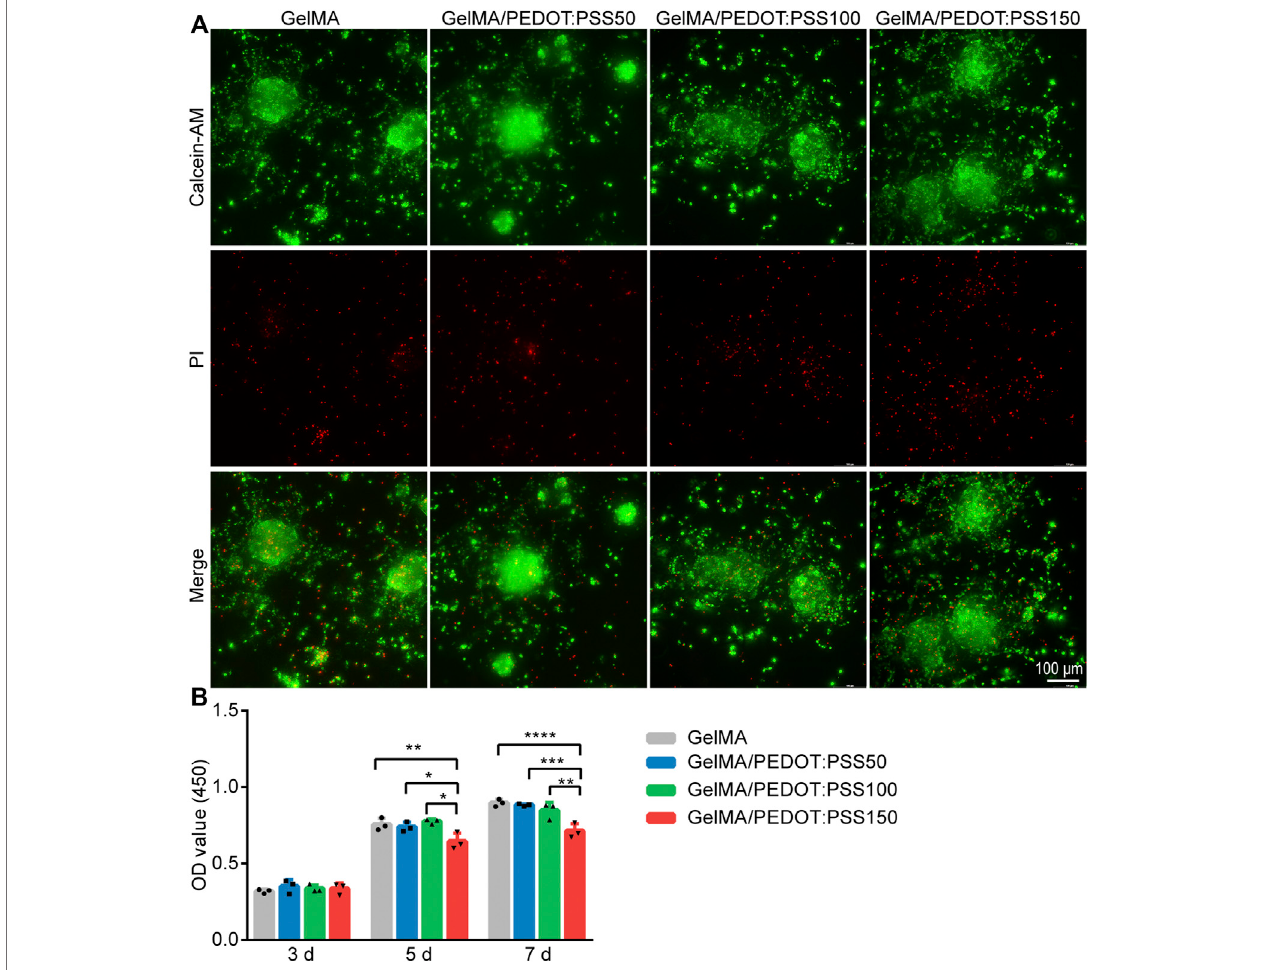
FIGURE 3 | NSC viability in the conductive GelMA/PEDOT: PSS hybrid hydrogels. (A) LIVE (green)/DEAD (red) NSC staining using Calcein-AM/PI staining after 7 days of culture. (B) Assessment of cell proliferation by the CCK-8 assay (n = 3), * p < 0.05 ** p < 0.01 *** p < 0.001, and **** p < 0.0001.